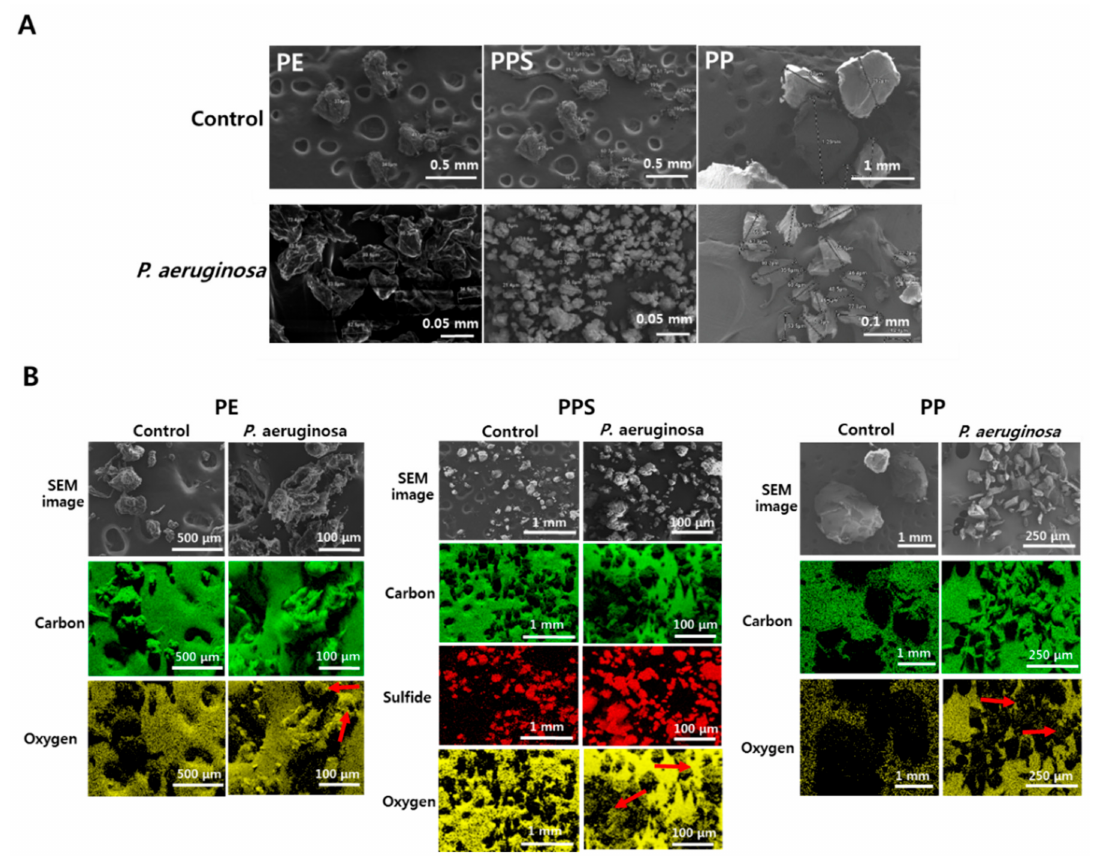
Figure 3. Scanning electron microscope (SEM) and elemental composition analyses of polyethylene (PE), polyphenylene sulfide (PPS) and polypropylene (PP) beads incubated with P. aeruginosa. ( A ) Comparison of size reductions for PE (left), PPS (middle) and PP (right) beads biodegraded by P. aeruginosa (lower) and control beads without bacteria (upper). ( B ) Detection of elemental composition on surfaces of three types of plastic beads, PE (left), PPS (middle) and PP (right). Green, yellow and red colors represent carbon, oxygen and sulfur (PPS) atoms. Unlike control without P. aeruginosa (left column), oxygen was strongly detected on the surface of plastic beads biodegraded by P. aeruginosa (red arrows in right